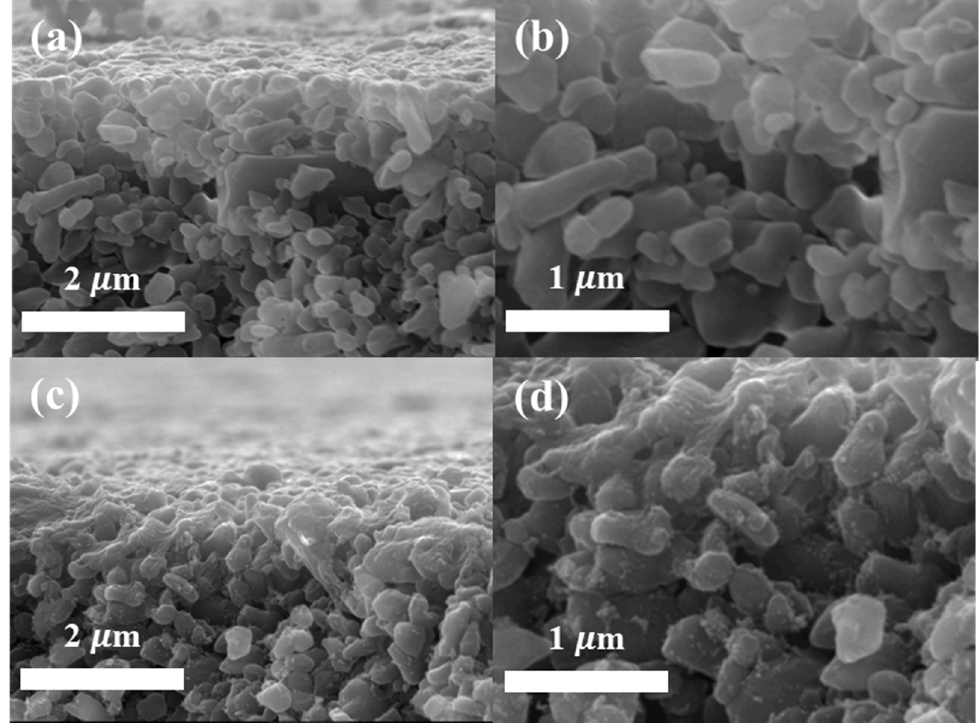
Figure 4. Cross sectional SEM images of the ( a , b ) bare Al 2 O 3 membrane and ( c , d ) POEM ‐ directed TiO 2 film on the Al 2 O 3 membrane.